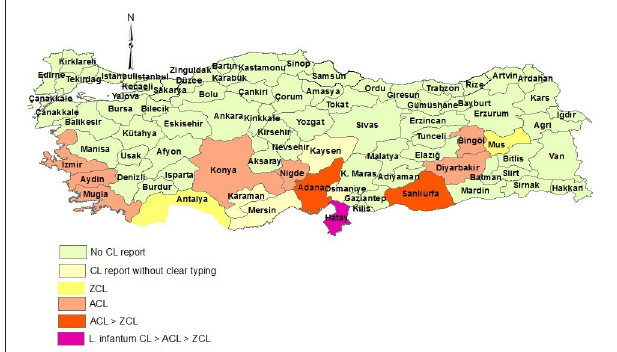
FIGURE 2 | Distribution of CL types in